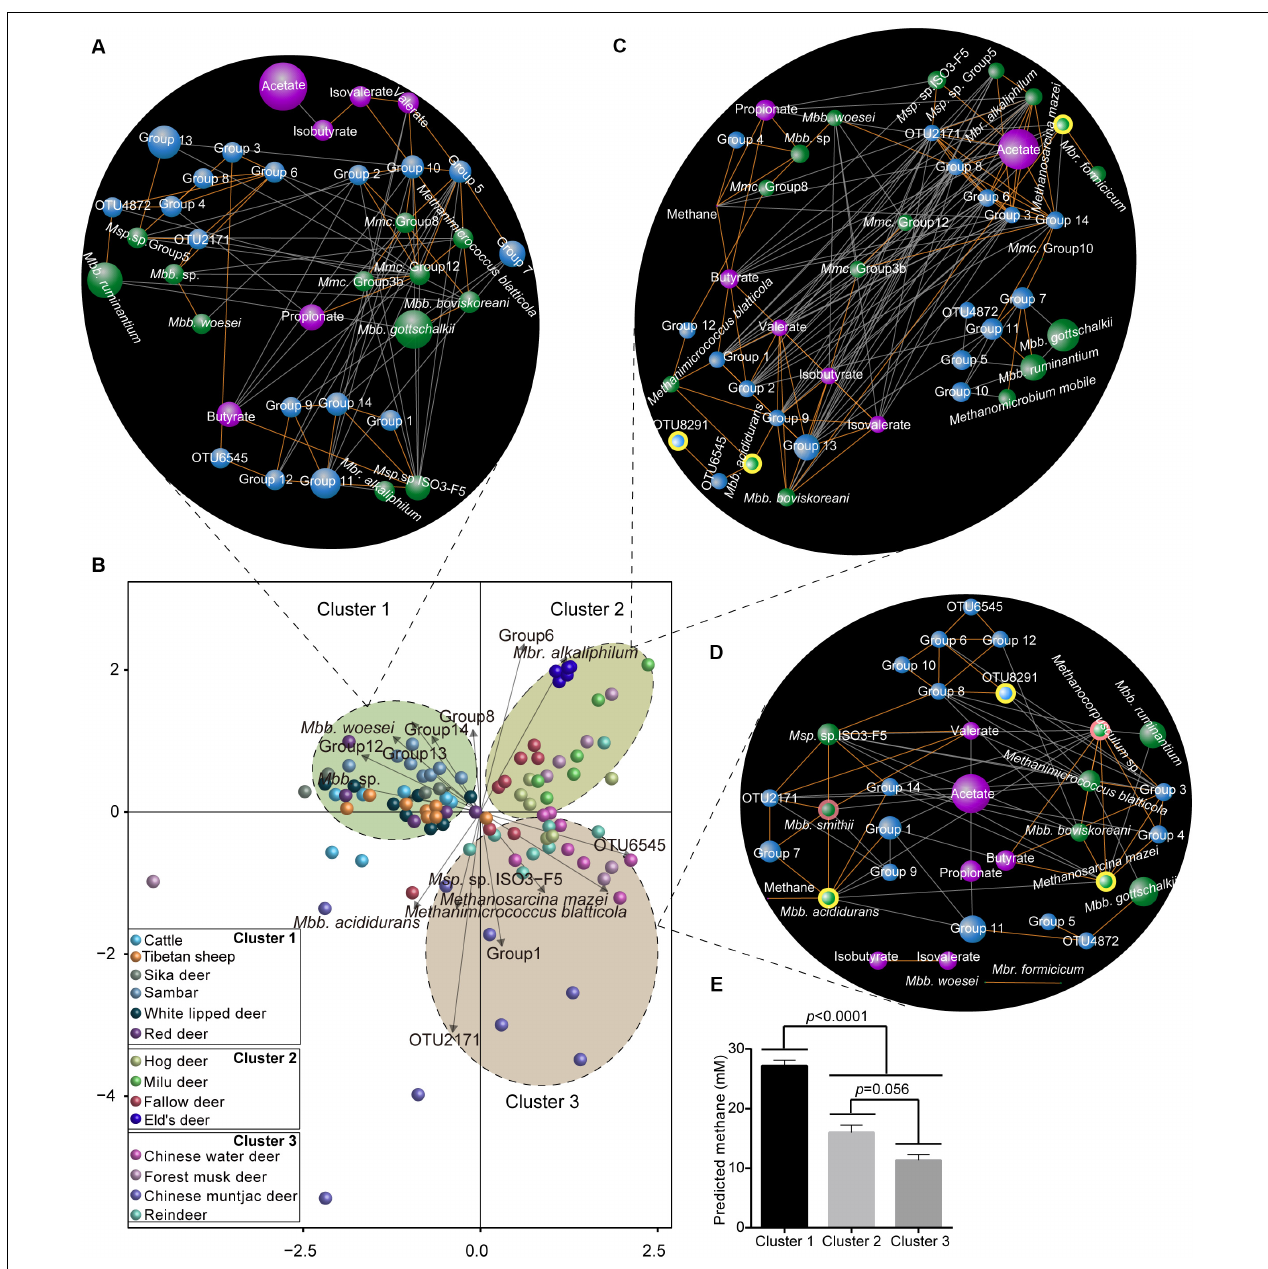
FIGURE 6 | Interactive relationships between methanogens, acetogens, and rumen metabolites. (A) Redundancy analysis showing the significant microorganisms ( p < 0.05) driving the rumen fermentation products across all the hosts based on the permutation test. Co-occurrence network of the rumen methanogens, acetogens, and fermentation parameters in cluster 1 ( B , high CH4 yield group), cluster 2 ( C , moderate CH4 yield group), and cluster 3 ( D , low CH4 yield group). Blue, green, and purple nodes represent acetogens, methanogens, and metabolites, respectively. Node size indicates the relative abundance of microorganisms or percentage of metabolites. The nodes with light yellow border represents the commonly changed microorganisms in networks 2 and 3 compared to network 1, and the nodes with a pink border indicate the changed microorganisms in network 3 compared to network 2. Each co-occurring pair has an absolute Spearman rank correlation above 0.50 [Gold line: positive correlation ( r > 0.90); gray line: negative correlation ( r < -0.50)] with an FDR-corrected significance level under 0.01. (E) Bar plots showing the amount of predicted CH 4 yields in three clusters. Mbb , Methanobrevibacter ; Msp , Methanosphaera ; Mbr , Methanobacterium ; and Mmc , Methanomassiliicoccaceae